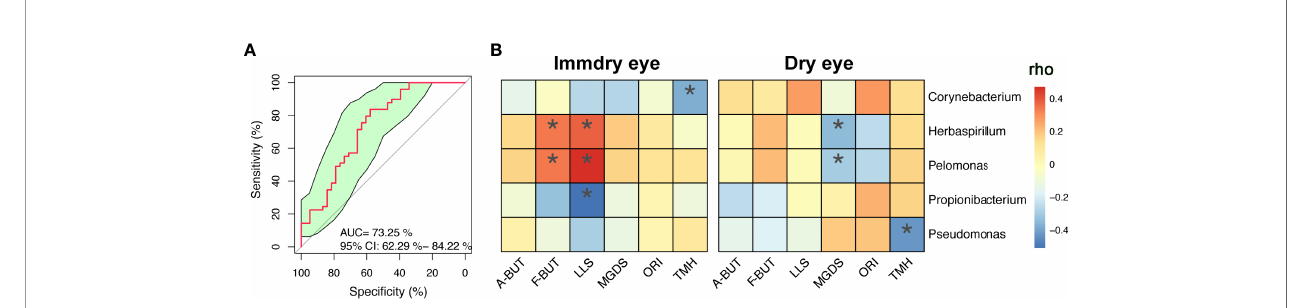
FIGURE 4 | Correlations between microbe abundance and the ocular surface parameters in the two groups. (A) Classi fi cation performance of the multivariable logistic regression model using relative abundance of genera (combination of Corynebacterium and Pelomonas ) was assessed using area under the ROC. (B) Heatmap showing partial Spearman ’ s correlation coef fi cients between the fi ve genera and the ocular surface parameters in the immdry eye and dry eye groups. A-BUT , average break of tear breakup time; F-BUT , the fi rst break of tear breakup time; LLS , lipid layer score; MGDS , Meibomian gland dropout score; ORI , ocular redness index; TMH , tear meniscus height; ROC , relative operating characteristic. * p < 0.05.